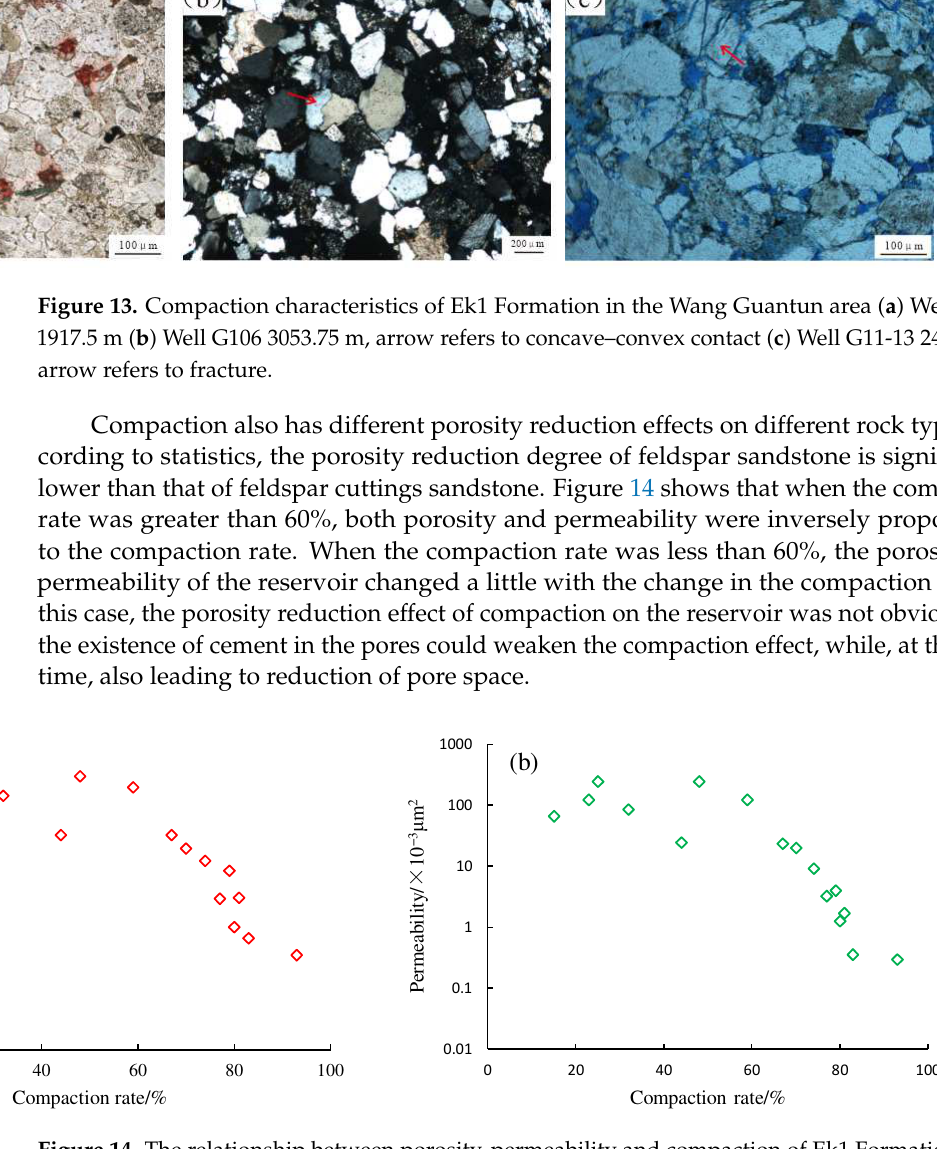
Figure 14. The relationship between porosity, permeability and compaction of Ek1 Formation in the Wang Guantun area. ( a ) porosity and compaction; ( b ) permeability and Wang Guantun area . ( a ) porosity and compaction; ( b ) permeability and compaction.